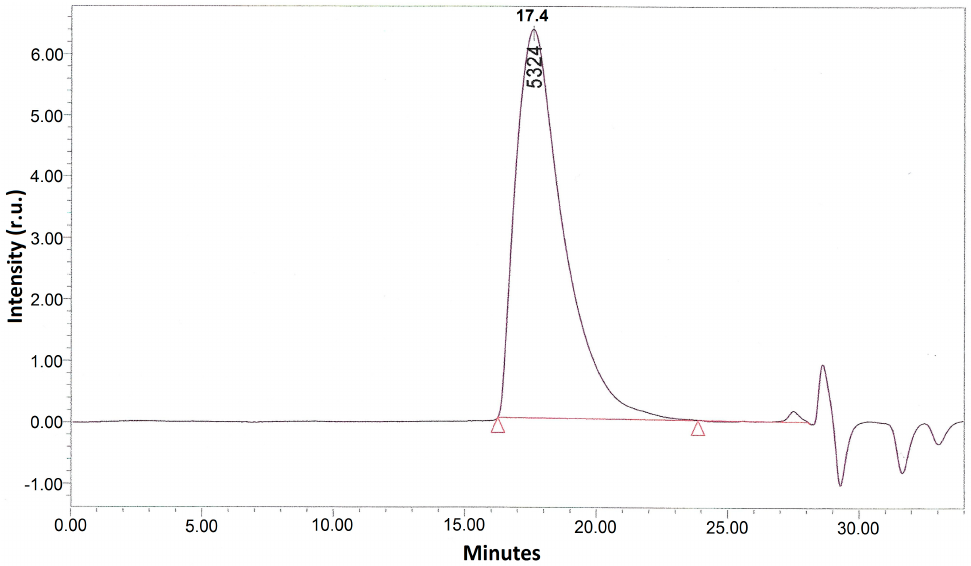
Figure 7. IR spectrum of the reaction mixture obtained at the second stage, after its purification by reprecipitation.